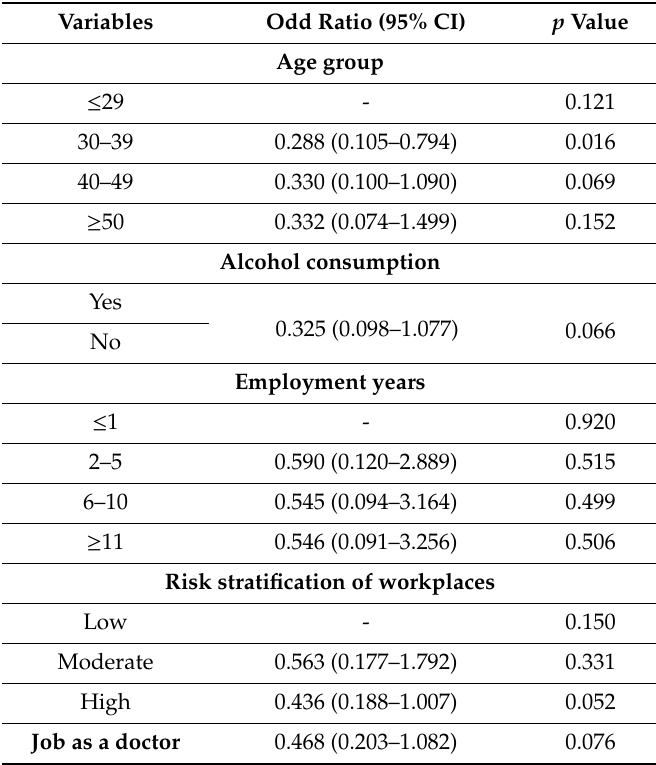
Table 3. Multivariate analysis of associated risk factors with positive IGRA